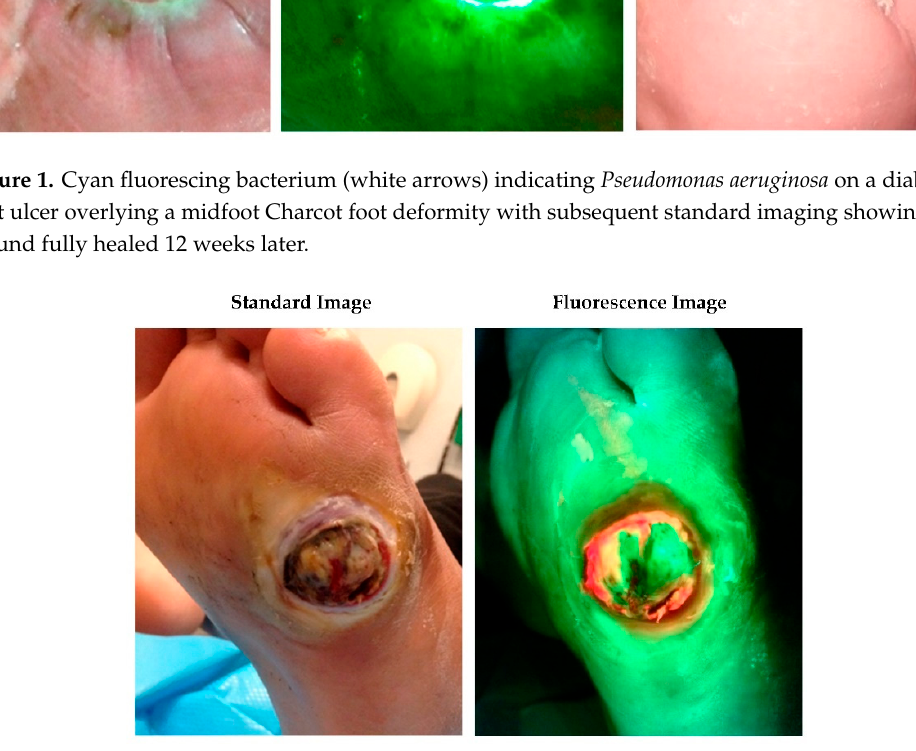
Figure 2. 34-year-old male with extremely poorly controlled type 1 diabetes presented to the foot clinic with a 3-week history of a ‘blister’ underneath his left foot. Analysis of a deep tissue sample taken using a scalpel and forceps and targeted to the region of red fluorescence, confirmed + Group B Streptococcus, + Coagulase-negative staphylococci, + Staphylococcus aureus , ++ Streptococcus oralis present in the wound. Based on the fluorescence imaging information, overall clinical presentation and x-rays confirming active osteomyelitis, he was admitted to hospital immediately and started on the appropriate intravenous antibiotics. He underwent a left 4th and 5th digital amputation and debridement approximately 5 days later but went on to make a full recovery with no further complications.